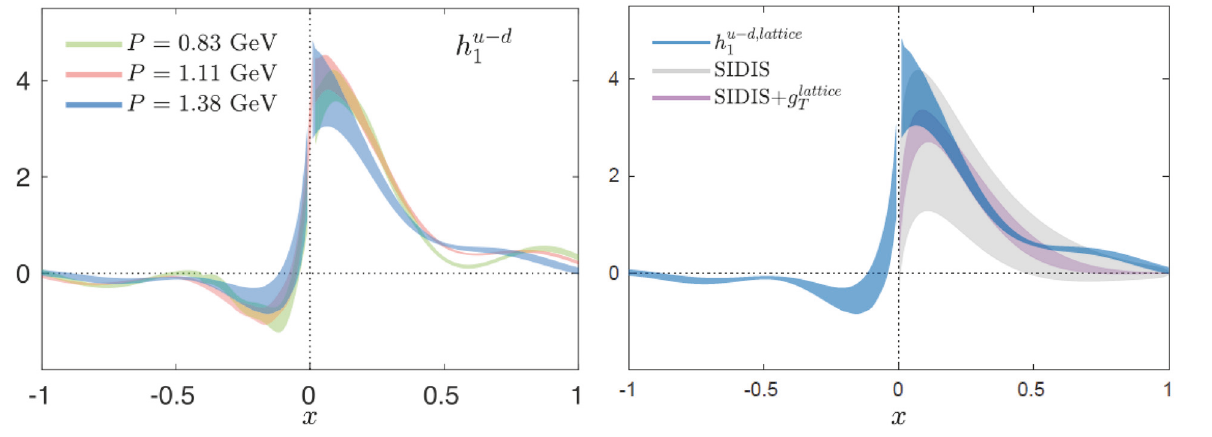
Figure 25: ETMC’s transversity PDF with momentum 1.38 GeV (blue) as a function of Bjorken- 𝑥 , at renormalization scale of √2 GeV. The phenomenological fits have been obtained using SIDIS data (grey) [220] and SIDIS data constrained using 𝑔 lattice 𝑇 (purple) [220]. Source: [48], reprinted with permission by the Authors (article published under the terms of the Creative Commons Attribution 4.0 International license).